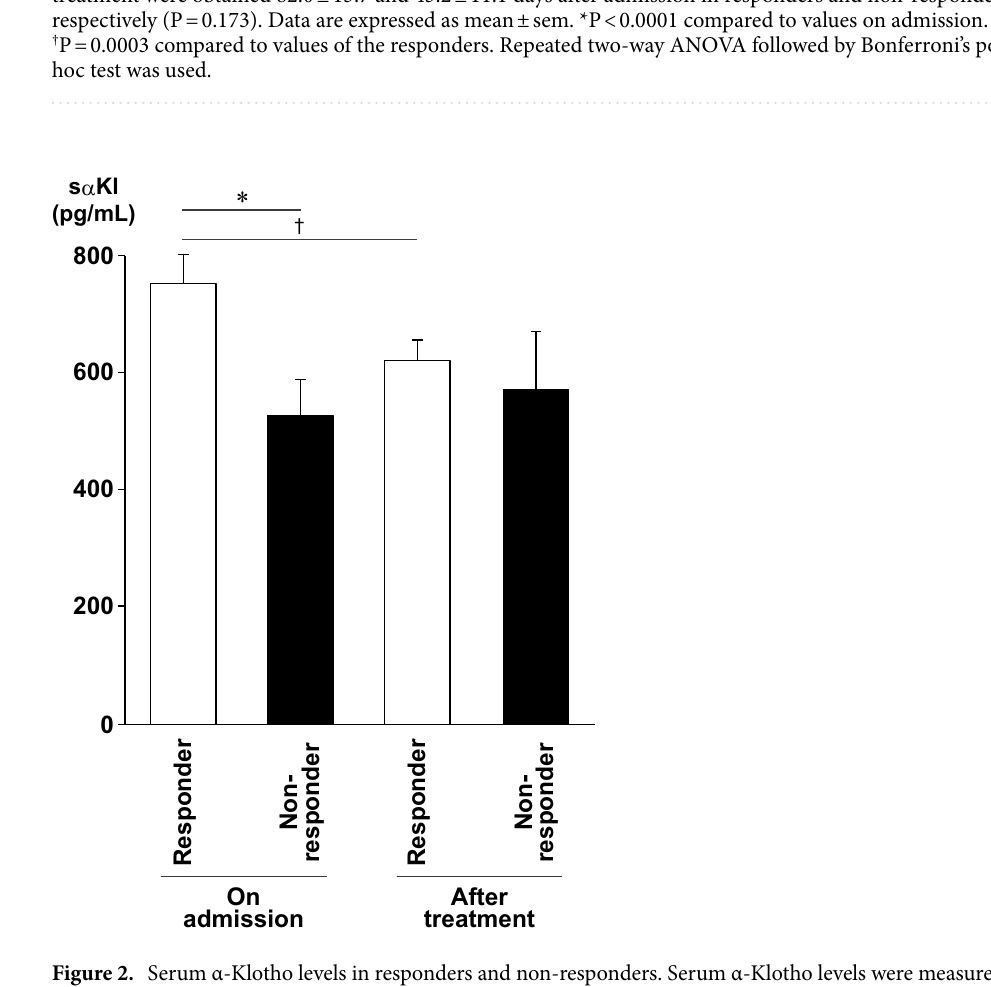
Figure 2. Serum α-Klotho levels in responders and non-responders. Serum α-Klotho levels were measured in patients with heart failure on admission and after treatment. Values are expressed as mean ± standard error of mean (sem). White and black bars indicate responders (n = 22) and non-responders (n = 6), respectively. *P = 0.0347. †P = 0.0027. Repeated two-way ANOVA followed by Bonferroni’s post hoc test was